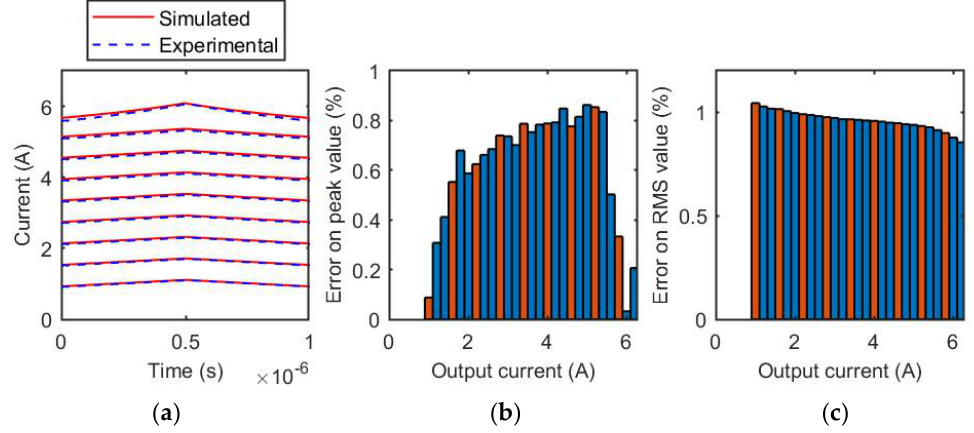
Figure 14. Coilcraft SER1390-333 inductor, 1 MHz. ( a ) Comparison of experimental and simulated current waveforms for different output current values; ( b ) relative error of the estimation of the peak value of the inductive current for each tested output current value. The orange bars represent the test cases reported in ( a ), the blue bars are related to the other measurements of the evaluated current range; ( c ) relative error of the estimation of the RMS value of the inductive current for each tested output current value. The orange bars represent the test cases reported in ( a ), the blue bars are related to the other measurements of the evaluated current range.